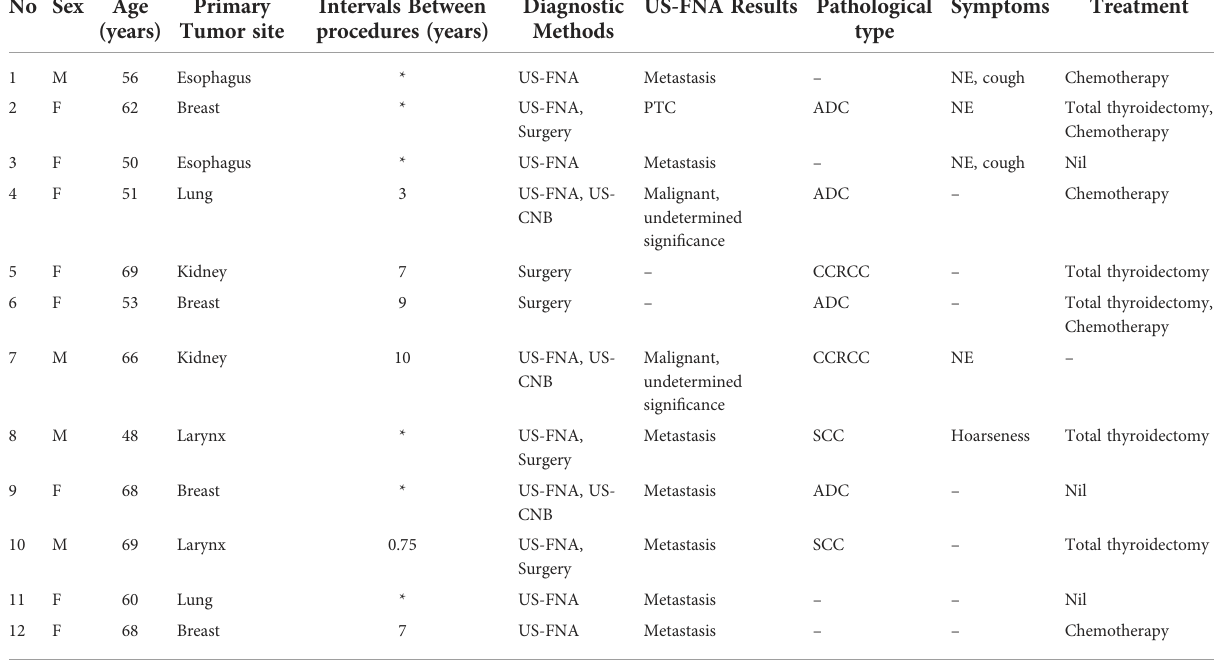
TABLE 1 Clinical data of patients with metastases to the thyroid